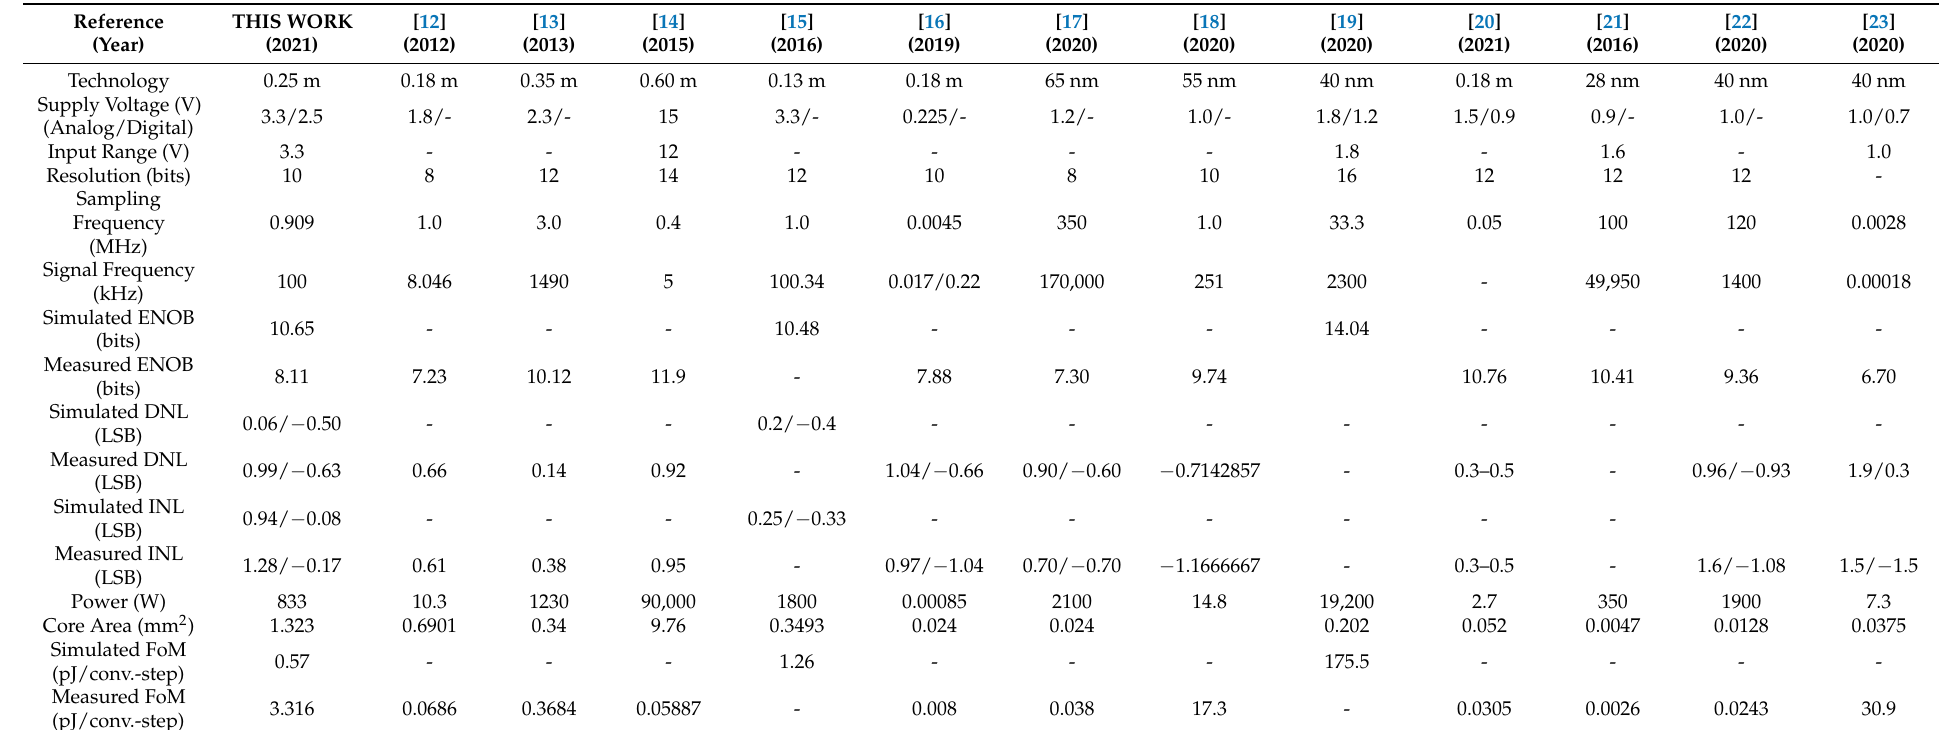
Table 5. Performance summary and comparison with other SAR